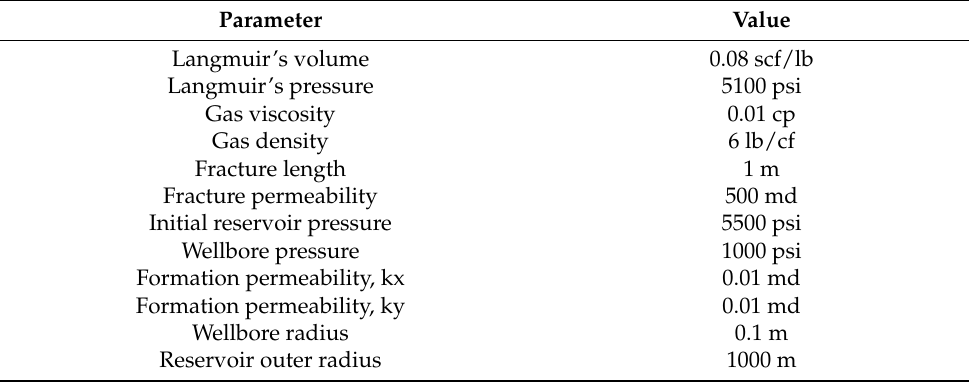
Figure 2. 2-D mesh used for the validation of the numerical model developed in this study. Table 1. Parameters used in the verification of the developed numerical model.